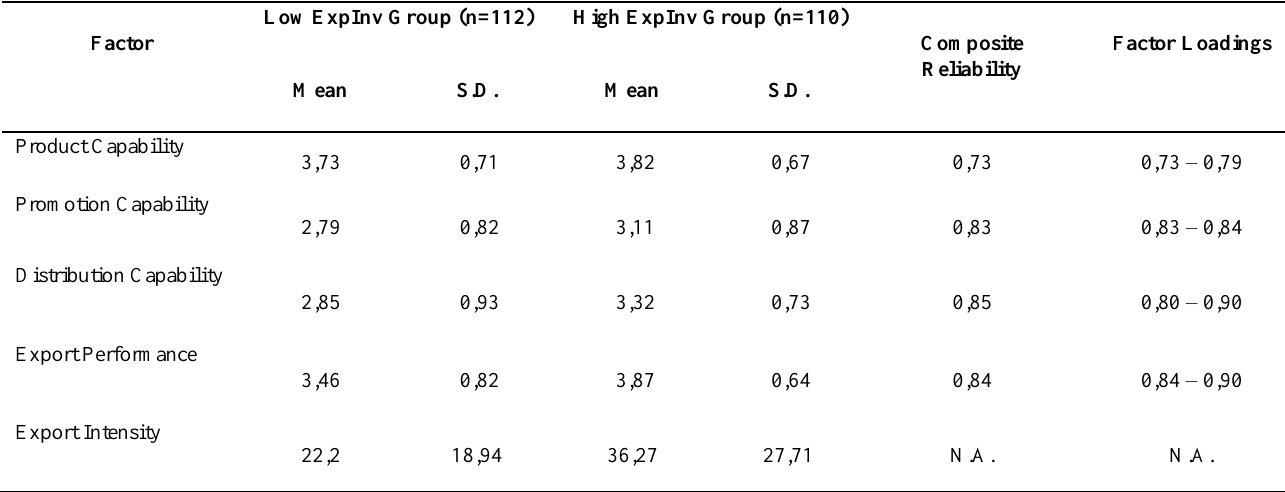
Table 1: Means, standard deviations, and confirmatory factor analysis results